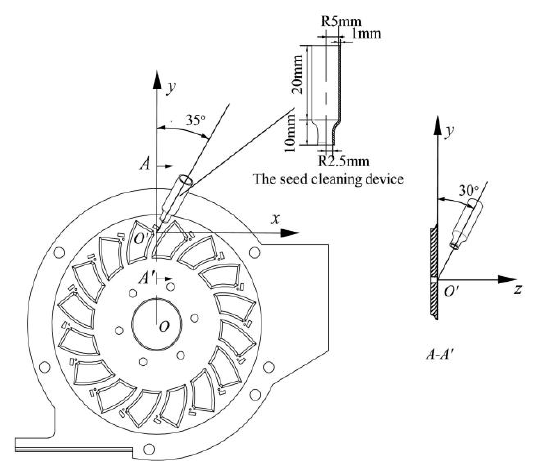
Figure 6. Schematic diagram of the structure and installation of the cleaning mechanism: A-A’ is the section view; O is the center of the seed plate; O' is the centroids of the rice seed; x , y and z are the coordinate axes.